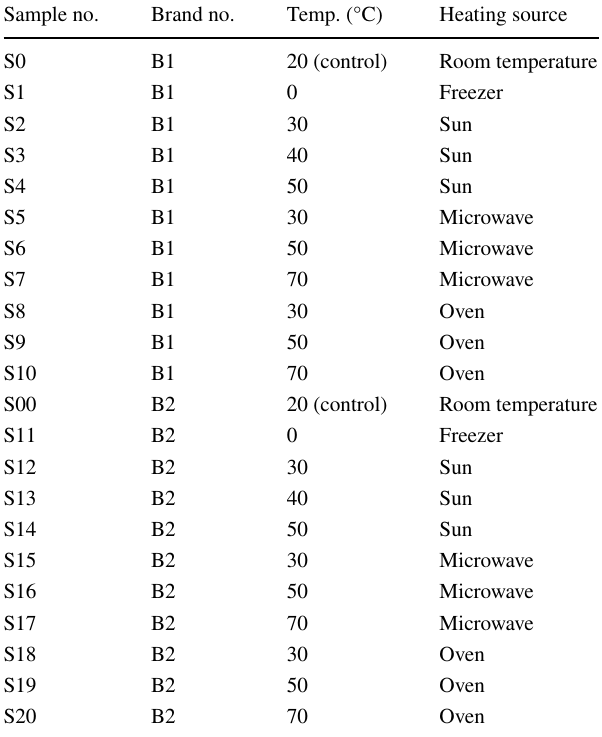
Table 1 The experiment schedule Sample no.